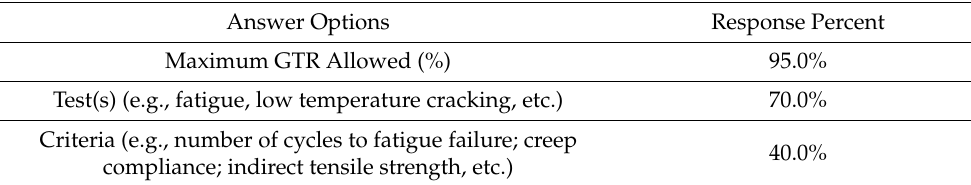
Table 16. Criteria used for surface course mixes containing GTR. Please Specify Test(s) and Criteria Used to Set the Maximum GTR Content (%) Limit in Surface Course.